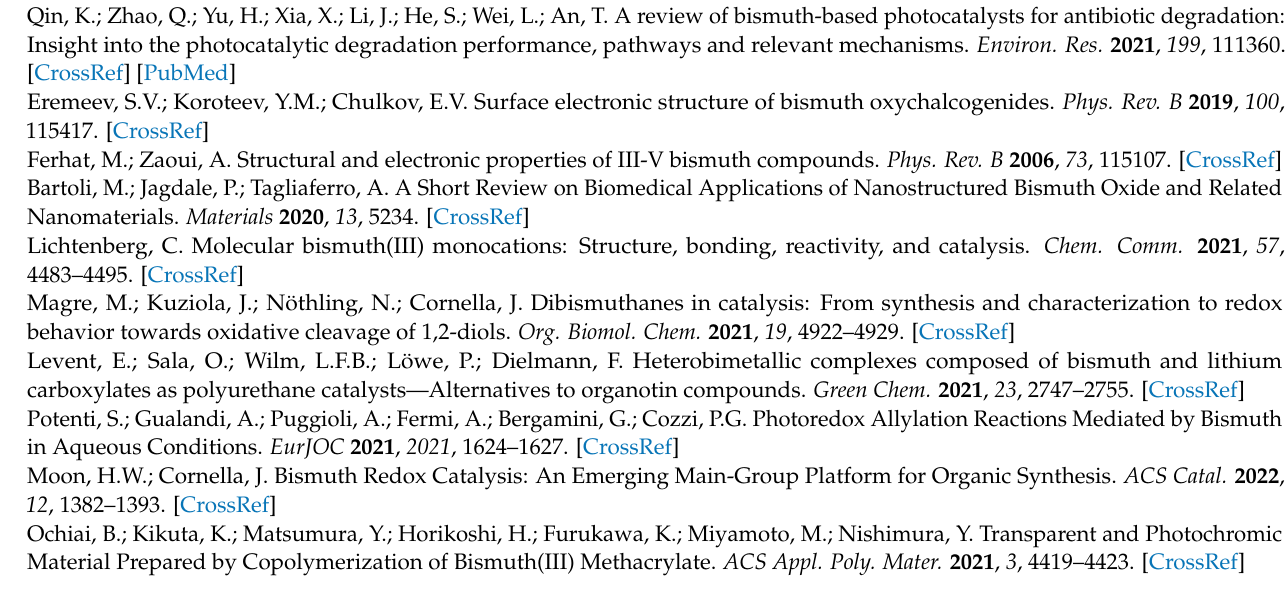
Figure S4. PXRD pattern of [Bi 38 O 45 (NO 3 ) 20 (dmso) 28 ](NO 3 ) 4 · 4dmso ( A , green) and [Bi 38 O 45 (Boc– Phe–O) 24 (dmso) 9 ] powder ( 2 , black); Figure S5. Exemplary particle size distribution (PSD) of [Bi 38 O 45 (NO 3 ) 20 (dmso) 28 ](NO 3 ) 4 · 4dmso ( A ), ( a ) and 2 in dmso ( b ), in acetonitrile ( c ) and in ethanol ( d ). The data for PSD curve of A were used with permission from ref [63]; Table S2. FTIR vibration modes of 2 associated with FTIR spectrum in Figure 1 and Figure S4 ( a ) 2 , ( b ) 2 –DrA, ( c ) 2 –DrE, ( d ) 2 –SpA and ( e ) 2 –SpE ( f ) 2 –DrA–2 ( g ) 2 –DrE–2 (values given in cm –1 ); Figure S6. FTIR spectra for drop and spin coated films, 2 dissolved in ethanol (DrE and SpE) and acetonitrile (DrA and SpA) and double coated films from 2 dissolved in ethanol and acetonitrile for drop coated samples (2 –DrE–2 and 2 –DrA–2); Figure S7. Profilometry of deposited films from bismuth oxido cluster 2 dissolved in ethanol (DrE) and in acetonitrile (DrA), respectively; Figure S8. Comparison of XRD of compound 2 and drop coated films of 2 from ethanol ( 2 –DrE) and acetonitrile ( 2 –DrA) solution; Figure S9. Comparison of XRD of compound 2 , spin coated samples of 2 from ethanol 5 µ L and 1000 rpm, ethanol with 20 µ L and 2000 rpm ( 2 –SpE), and from acetonitrile 20 µ L and 2000 rpm ( 2 –SpA)